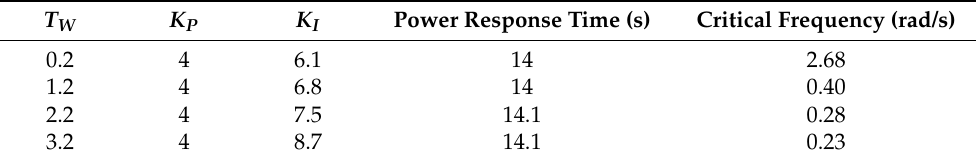
Table 1. The parameters in ORM.